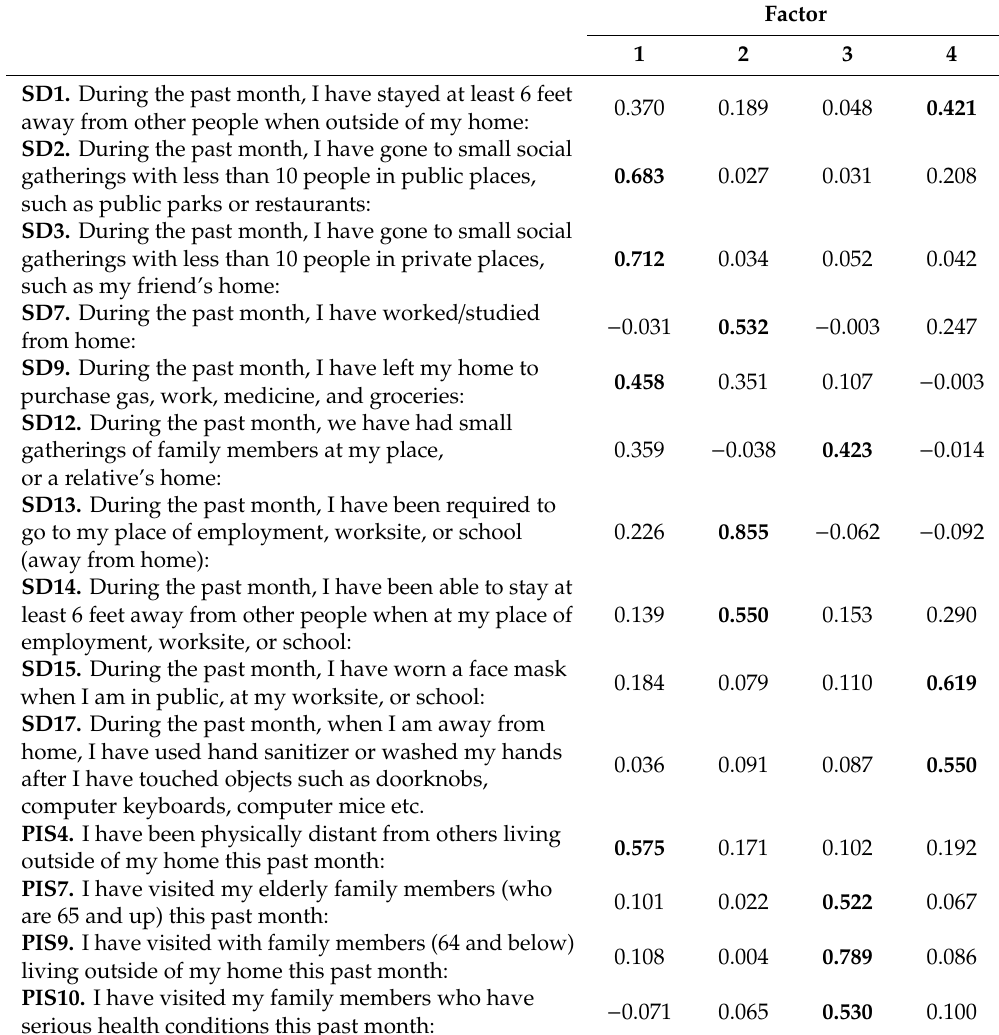
Table 3. Factor loadings Based on a Principal Axis Factoring and Varimax Rotation a for 14 items from the Social Distance Item Pool ( n = 401).